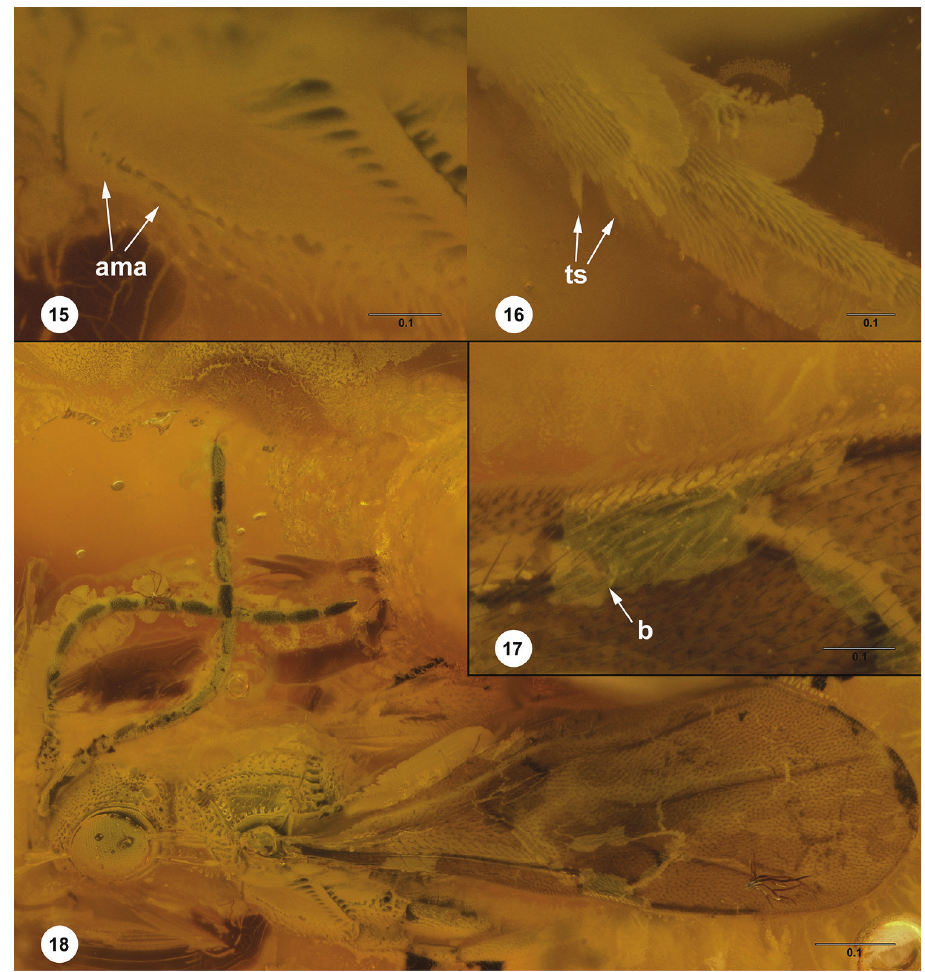
Figures 15–18. Archaeoteleia sp., male (USNMENT01223663) 15 mesopleuron, dorsolateral view 16 distal apex of metatibia, lateral view 17 fore winge venation, dorsal view 18 head and mesosoma, dorsolateral view. Scale bars in